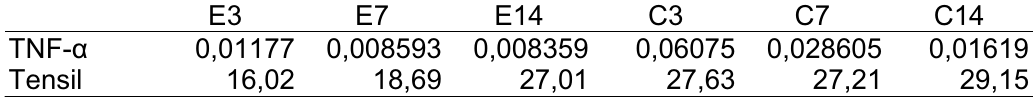
TABLE 2 - TNF- α values in ng / ml and tensile strength in N according to subgroups of animals treated with infliximab (E3, E7 and E17) and subgroups treated with placebo (C3, C7 and